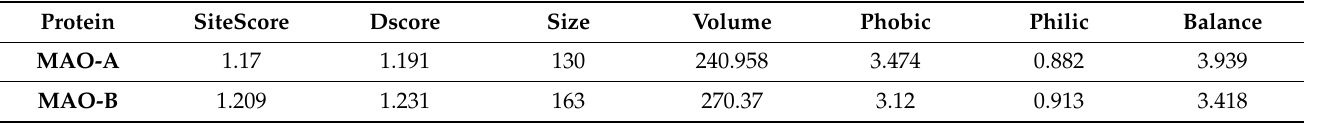
Table 3. SiteMap analysis of the E -stilbenol